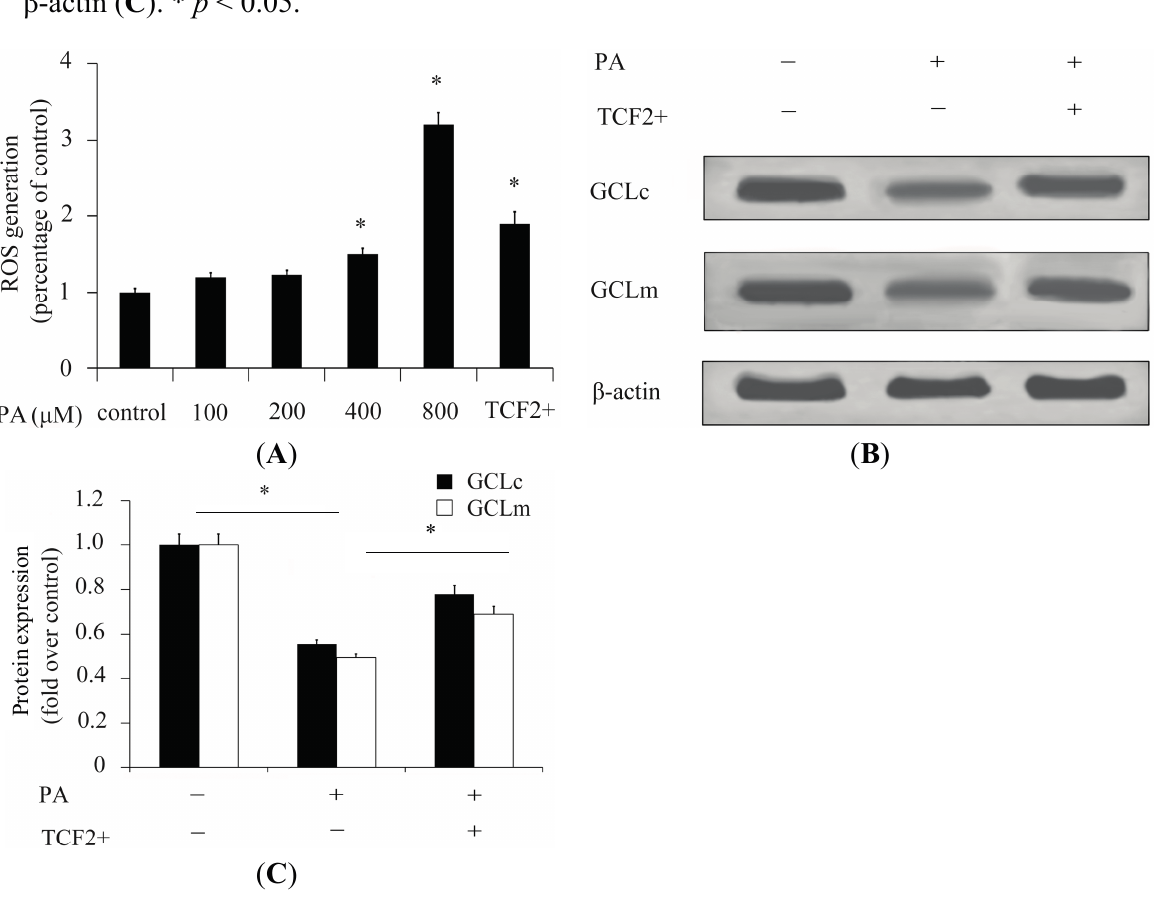
Figure 2. TCF2 inhibits the ROS activation stimulated by high concentrations of PA. ROS generation in INS-1 β -cells was analyzed after treatment with a concentration gradient of PA for 24 h. ROS generation in INS-1 β -cells treated with PA (800 μ M) and overexpressing TCF2 was also analyzed ( A ); Expression of GCLc and GCLm was detected by Western blotting ( B ) in INS-1 cells overexpressing TCF2 or not; Levels in cells cultured in DMEM containing 25 mM glucose (control) or 800 μ M PA were quantified relative to β -actin ( C ). * p <